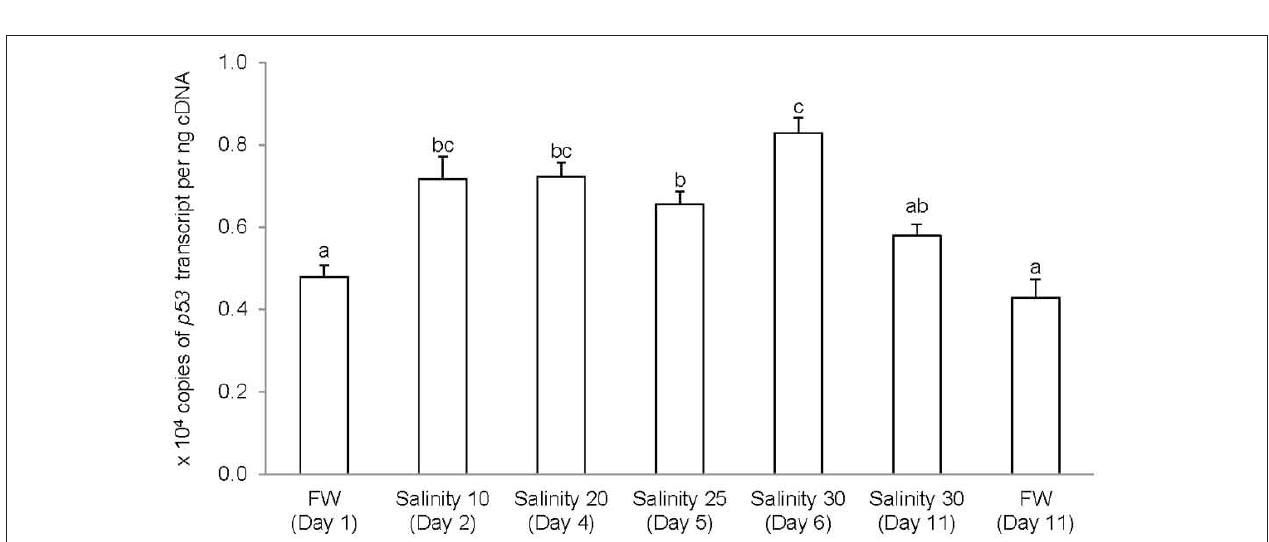
FIGURE 4 | Absolute quantification of p53 mRNA (copies of transcript per ng cDNA) in the gills of Anabas testudineus kept in freshwater (FW) for 1 or 11 days (controls), or exposed to a 5-day progressive increase in salinity (S) from FW (day 1) to S 10 on day 2, S 20 on day